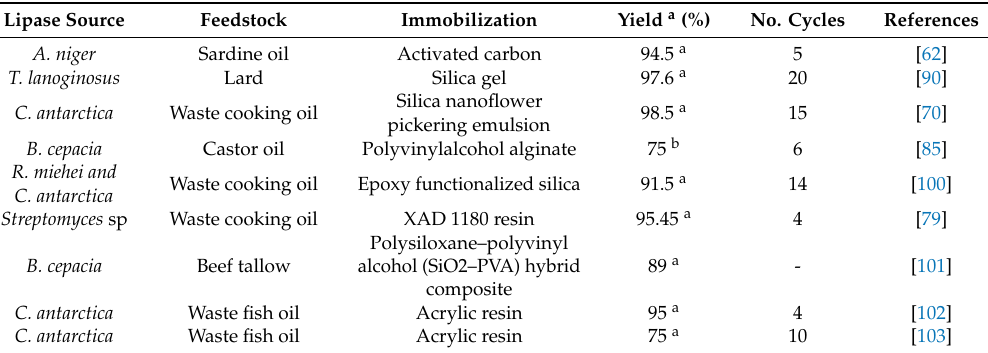
Figure 2. Major types of biological catalysis for biodiesel generation. Table 3. Biodiesel production with various immobilized lipases.